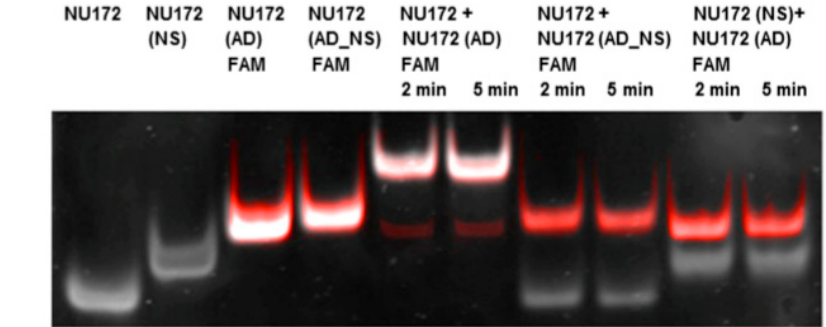
Figure 2. Analyses of specific binding of antidotes (ADs) to their target aptamers and the formation of aptamer/AD complexes using 10% nondenaturing polyacrylamide gel electrophoresis. Samples were analyzed after 2 and 5 min of incubation in human serum. ( A ) Analyses of R10-60 (AD_NS) FAM binding to the R10-60 aptamer and the R10-60 (NS) aptamer binding to R10-60 (AD) FAM; ( B ) Analyses of NU172 (AD_NS) FAM binding to the NU172 aptamer and the NU172 (NS) aptamer binding to NU172 (AD) FAM. Firstly, FAM-labeled ADs were detected using an UV-transilluminator (red colored bands) and then all oligonucleotides were detected using GelRed™ staining (white colored bands). An overlay of FAM and GelRed staining is presented.